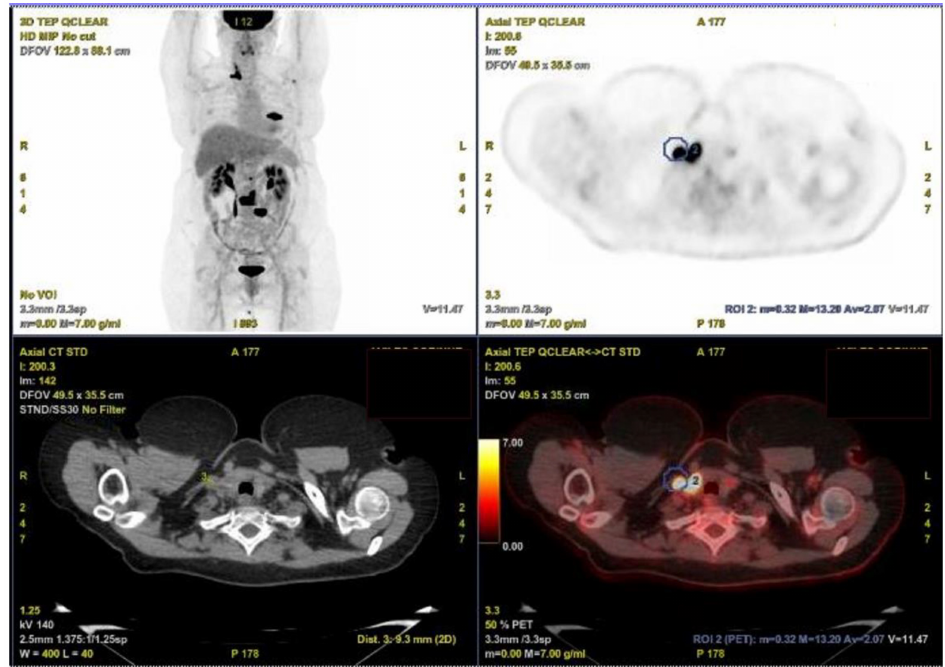
Figure 1. 18 F-FDG PET/CT scanner. Intense hypermetabolic focus (SUV max = 16.3) of the right thyroid lobe, with a second right hypermetabolic focus compatible with a specific thrombotic tumor invasion of the right IJV (9 mm, SUV max = 13.2) in the blue